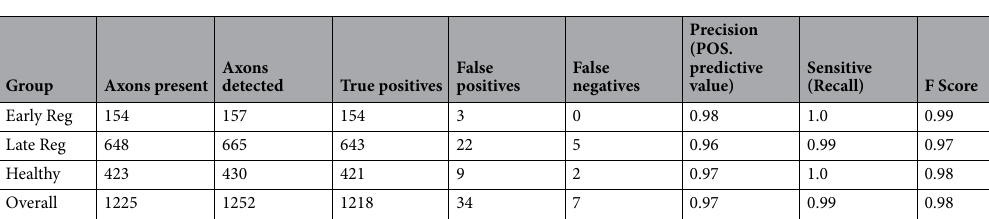
Table 2. The accuracy of automated axon segmentations using AxonDeepSeg in different nerve regeneration stages.